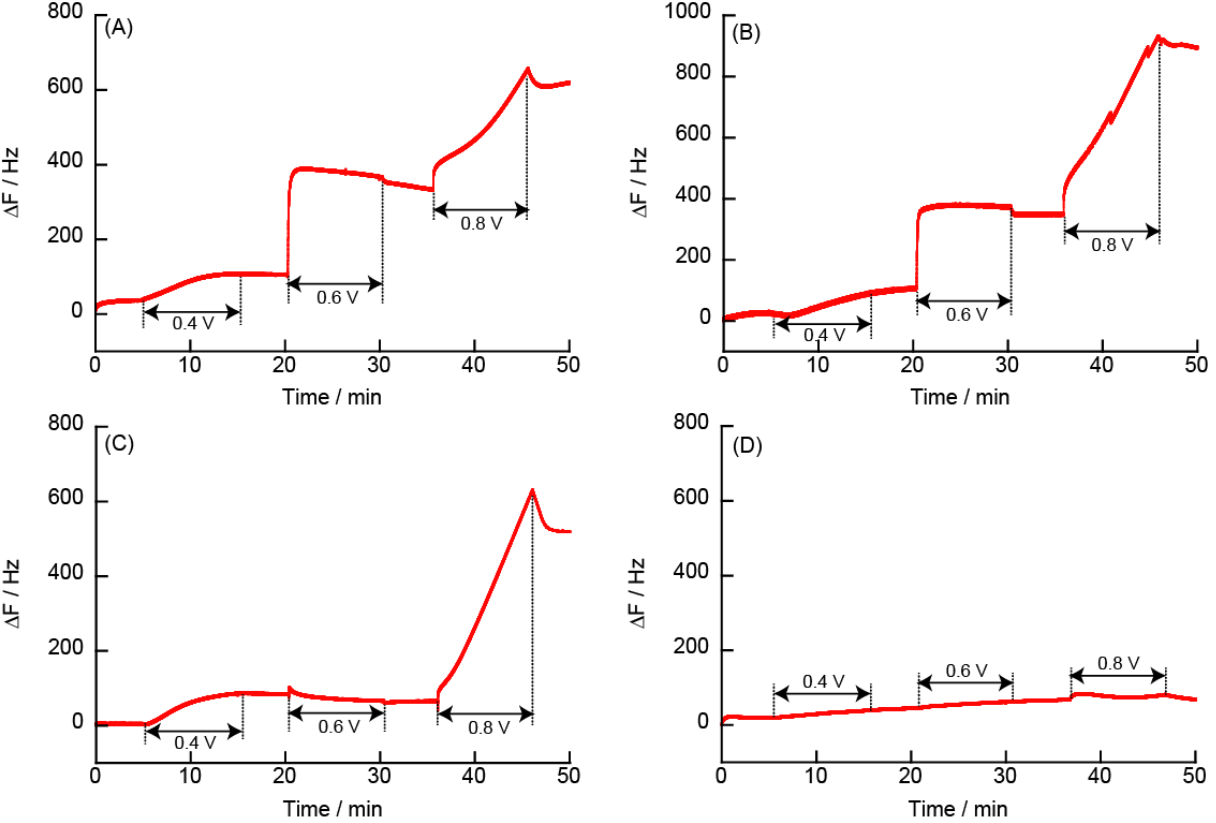
Figure 11. Changes in the resonance frequency for the ( A ) (PEI/TEMPO-PAA) 5 , ( B ) (PAH/TEMPO- PAA) 5 , ( C ) (PDDA/TEMPO-PAA) 5 , and ( D ) (PAMAM/TEMPO-PAA) 5 films with coating electrodes and constant potential. The electrode potential was applied at +0.4 V, +0.6 V, and +0.8 V for 10